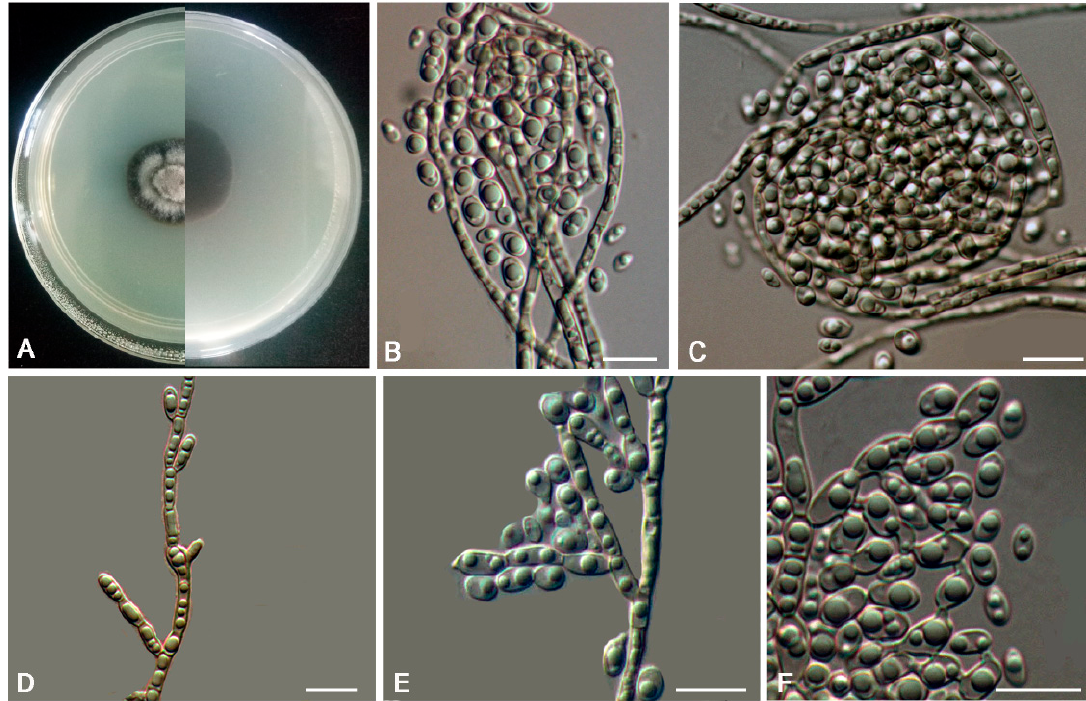
Figure 21. Exophiala ellipsoidea (CGMCC 3.17348). ( A ) Forward (left) and reverse (right) of colony on MEA. ( B , C ) Spirally twisted hyphae. ( D – F ) Conidiophores with branched conidial chains. Scale bars: ( B – F ) = 10 μ m.